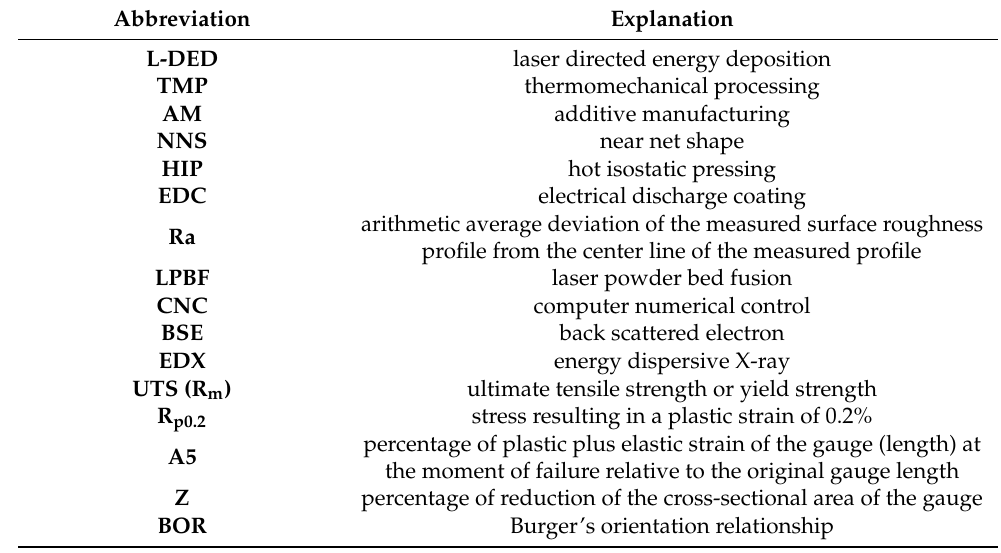
Table 1. Nomenclature used in the present study.